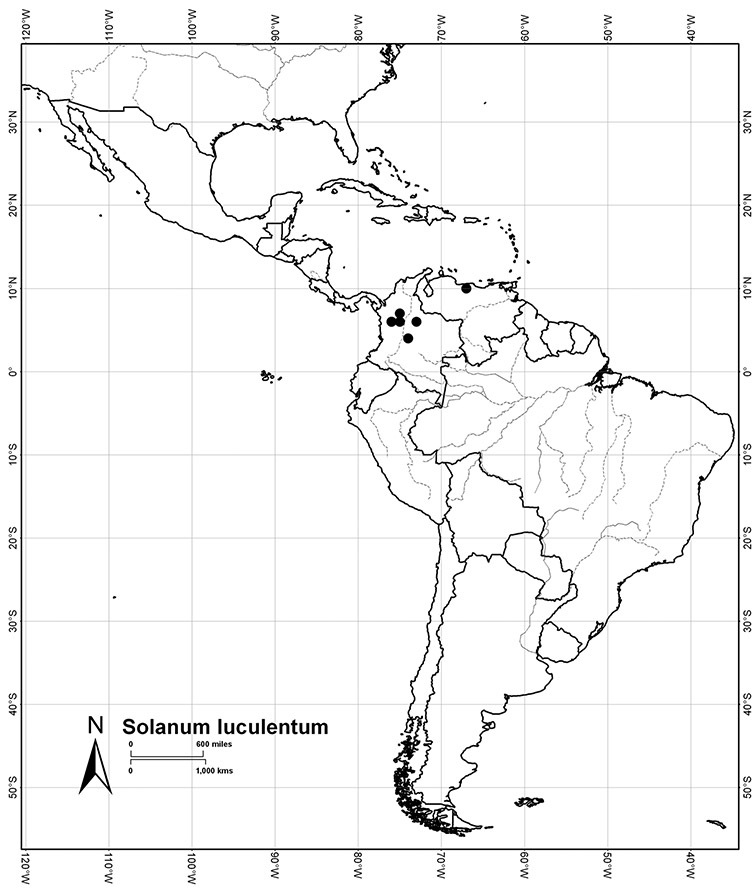
Distribution of Solanum luculentum S.Knapp.